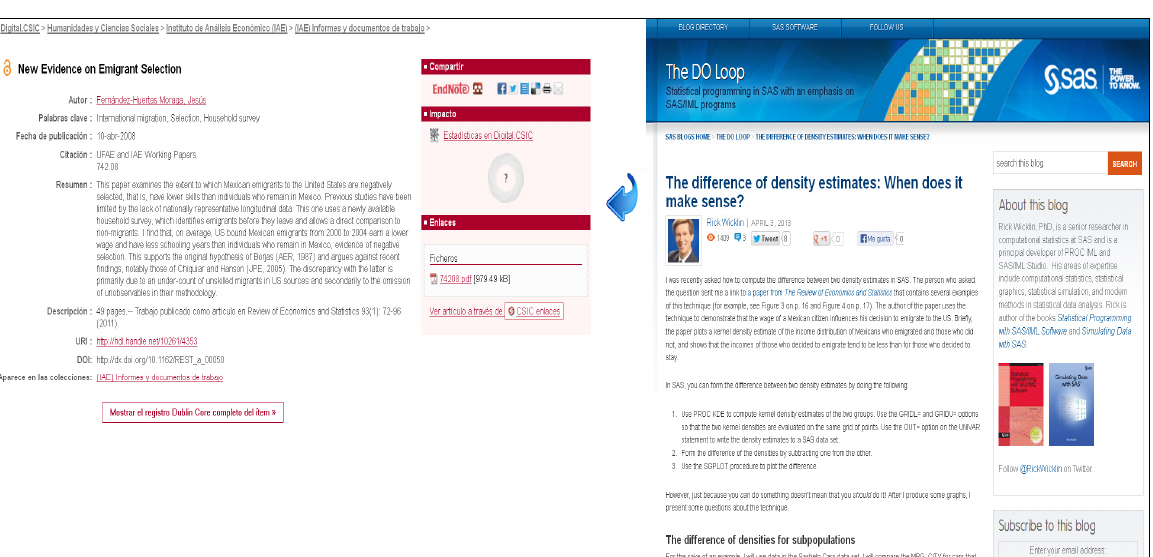
Figure 10. Working paper New Evidence on Emigrant Selection [44] is highlighted as a useful resource at the blog entry The difference of density estimates: When does it make sense? by a computational statistics